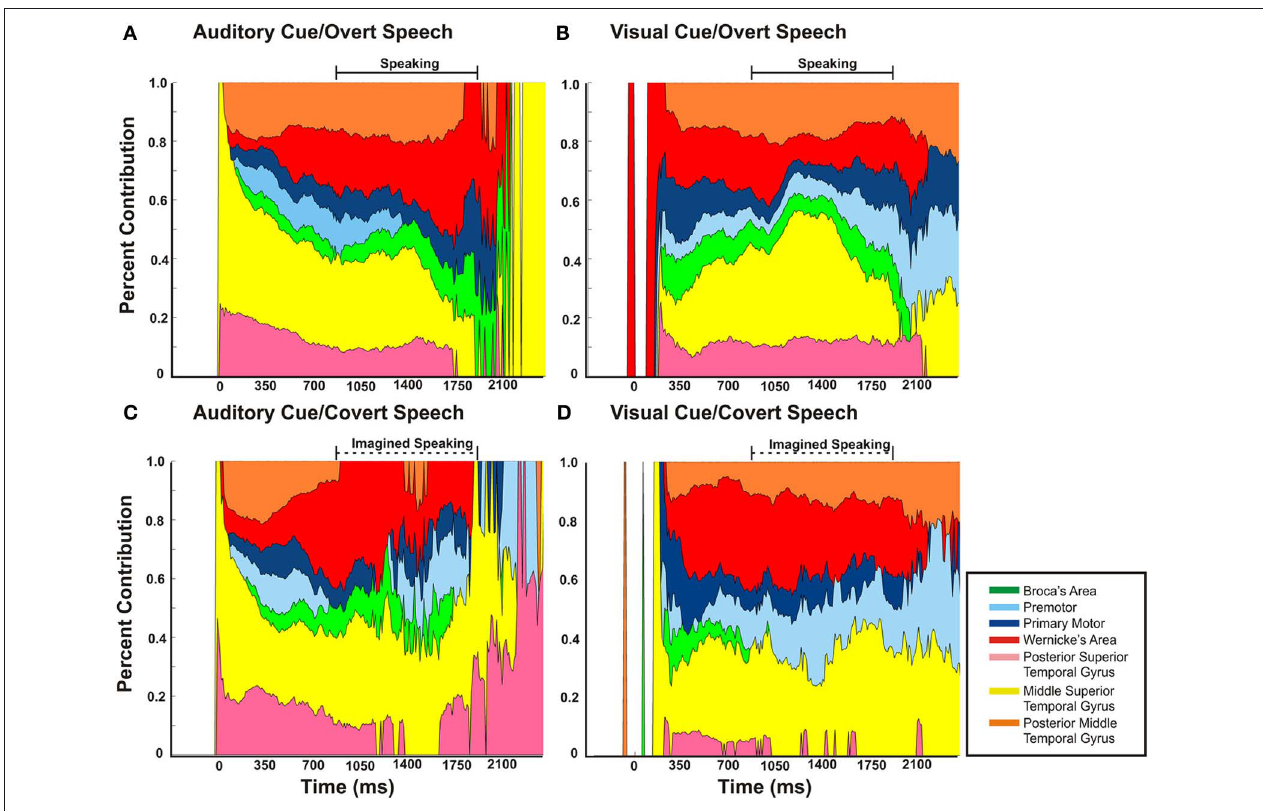
FIGURE 9 | The magnitude of cortical activation for a given region relative to the other sites over time for each of the four conditions. The activation of one region [as defined by the average of statistically significant r 2 ( p < 0 . 03) from all subjects] is defined as percentage relative to the total cortical activation (the sum of all statistically significant r 2 values at all regions across all patients for a given point in time). The barred solid